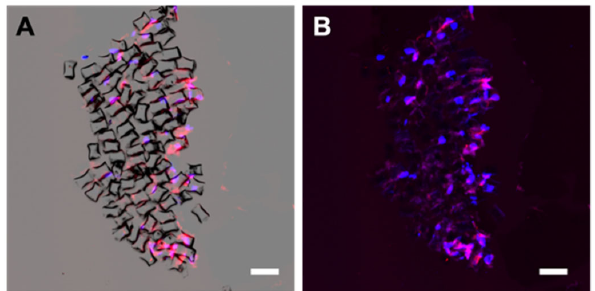
Figure 9. Schwann cells distribution in a transversal cut of the ‘neural cord’. Representative fluores- cent images of a transversal section of the ‘neural cord’ after nuclear staining with DAPI (blue) and F-actin of SC staining with ActinRed™ 555 ReadyProbes™ Reagent (red) with ( A ) and without ( B ) the bright field view. Scale bar: 100 μ m ( A , B ).